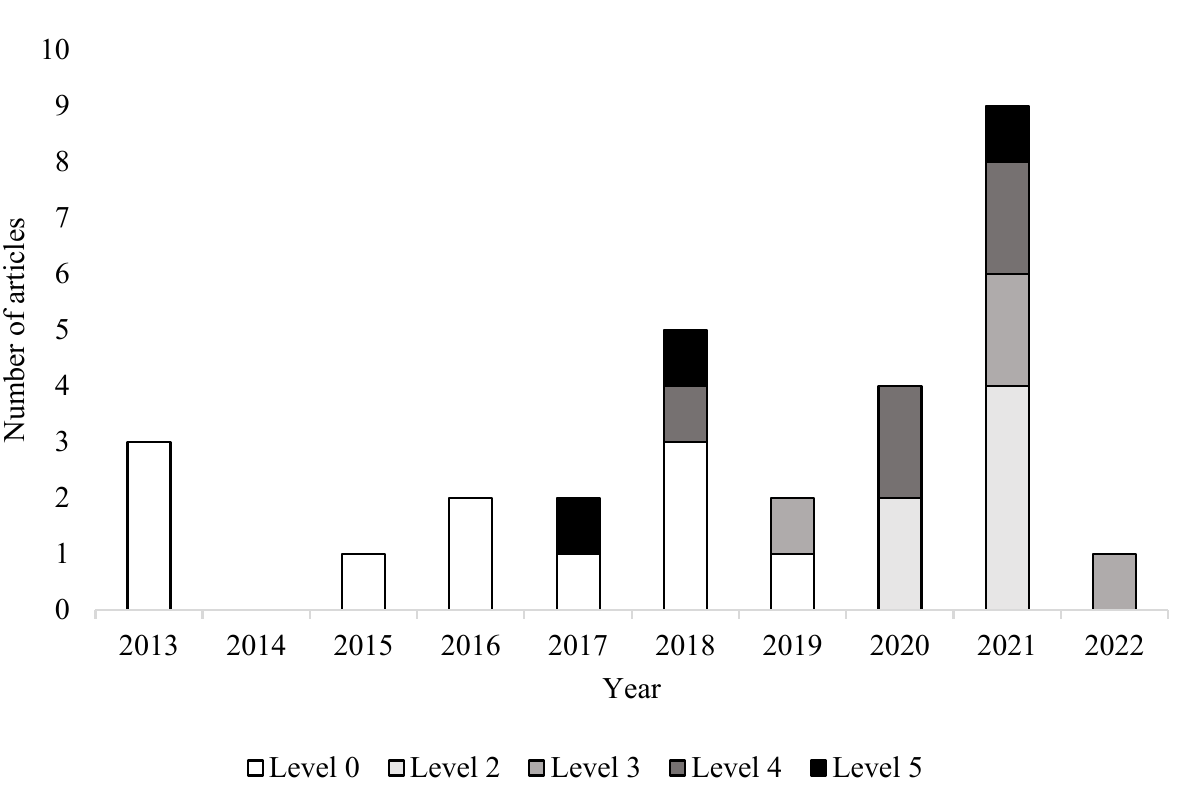
Figure 3. Automation level utilized in research articles by year.